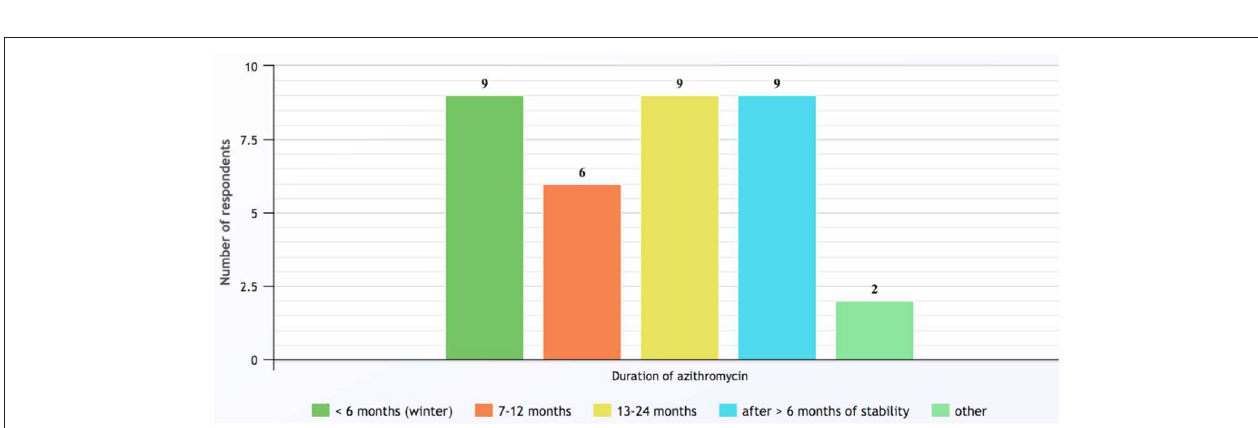
FIGURE 1 | Numbers of children with recurrent protracted bacterial bronchitis, chronic suppurative lung disease, and bronchiectasis seen by survey respondents annually (response to Q6).